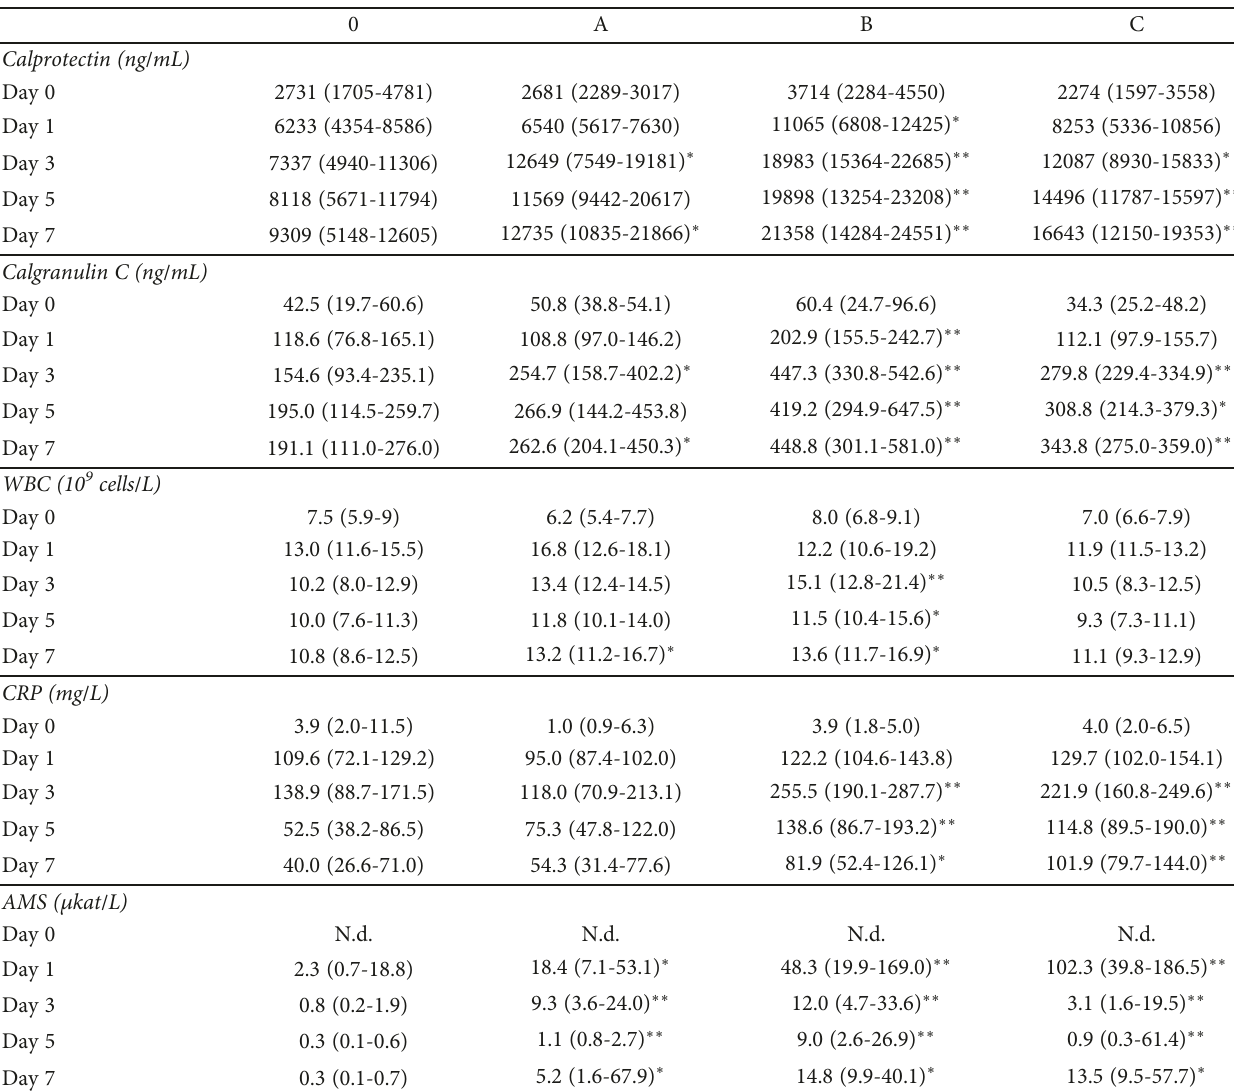
Table 3: The comparisons of the level of AMS in the pancreatic drainage fl uid; the levels of calprotectin, calgranulin C, and CRP in the serum; and the WBC count in patients with POPF grades A, B, and C and those with uncomplicated postoperative courses. 0 A B